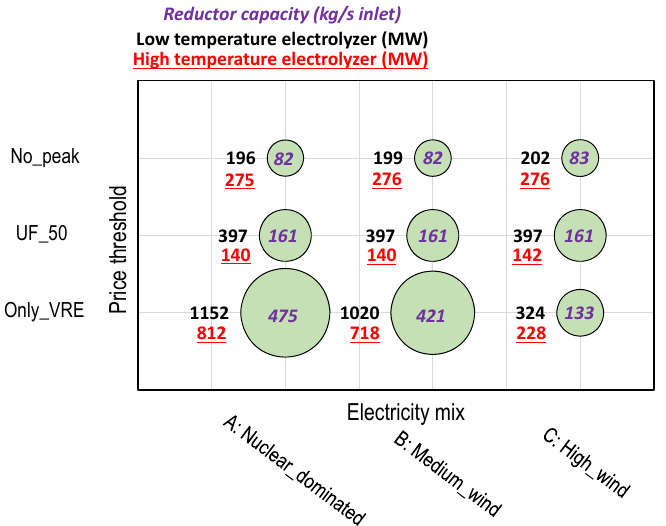
Figure 10. Capacities required for the electrolyzers (in MW, including both the high- and low-temperature cases) and the reduction reactor (in kg/s of inlet solids), for the nine scenarios under investigation.